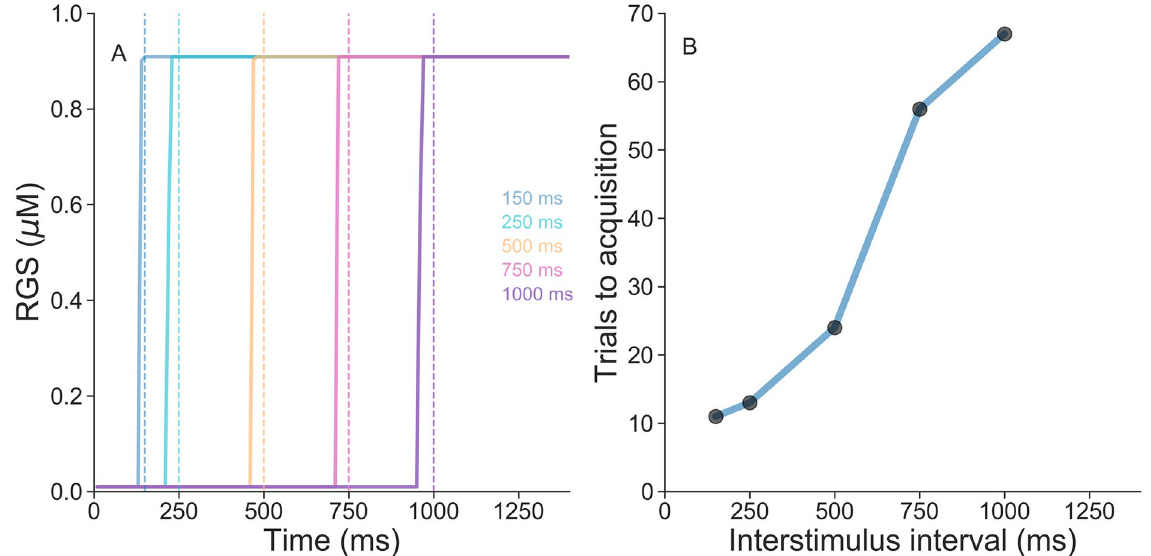
Fig 6. RGS protein anticipates CF signal for different time intervals. (A) Dashed line indicates the arrival of the climbing fiber input for the different inter-stimulus intervals. Continuous line shows the activation of RGS protein activity for the different inter-stimulus interval after 70 CS-US pairings. (B) Required number of pairings to learn a timed response for the different inter-stimulus intervals.